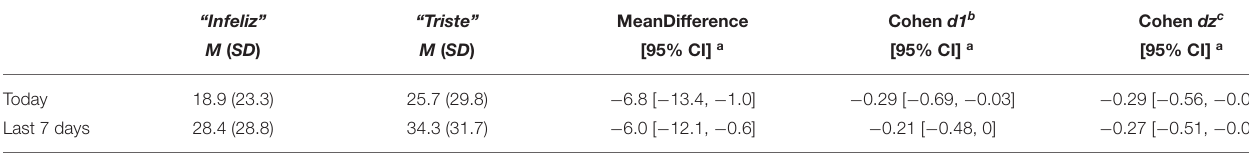
TABLE 1 | Mean, standard deviations, difference, confidence intervals, and effect size between “ infeliz ” and “ triste ” for today and last 7 days (substudy 2). “Infeliz”